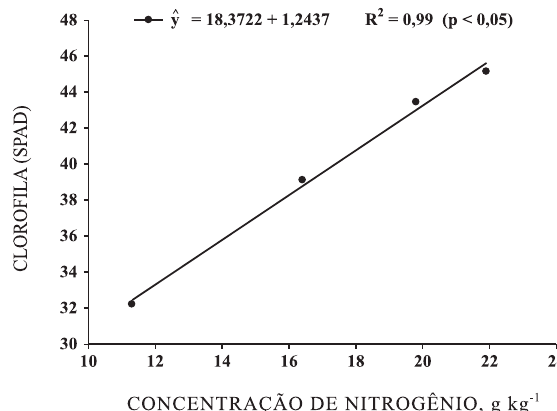
- na folha do capim- Figura 5. Teores de N-NO 3 marandu em função de doses de nitrogênio (média de três cortes por